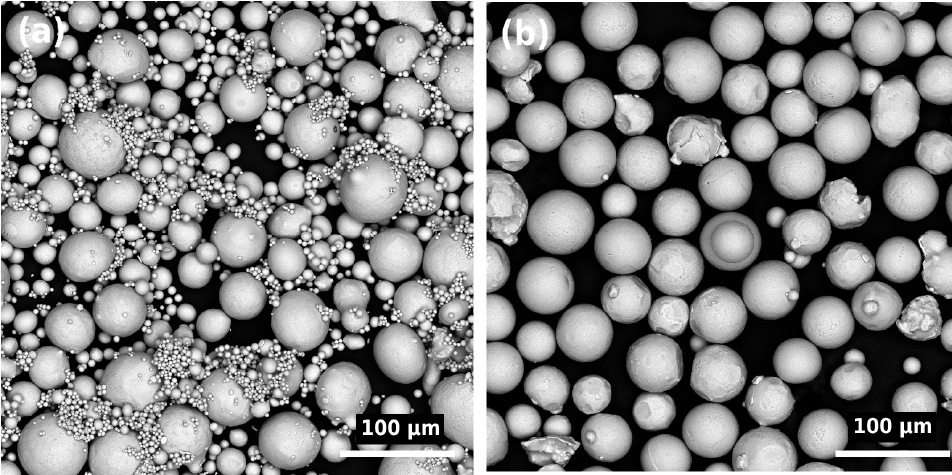
Figure 1. Scanning electron microscope (SEM) images of ( a ) Ti2AlNb and ( b ) Ti64 powders.